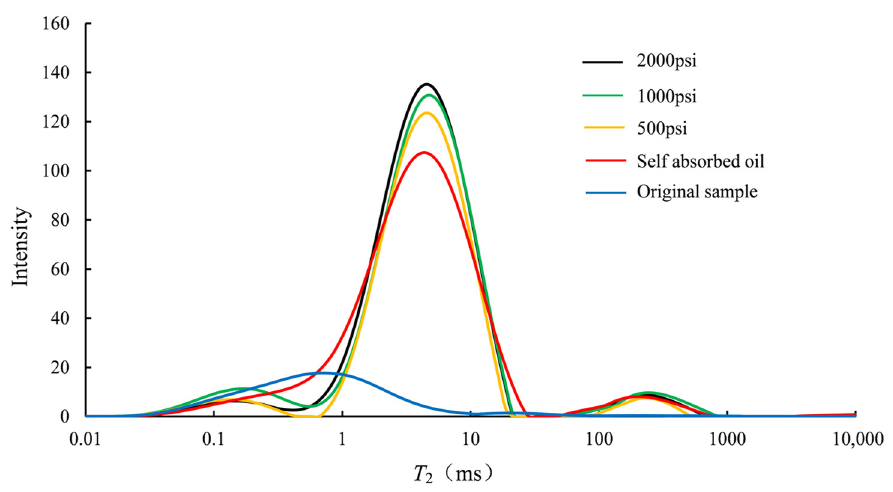
Figure 3. T 2 spectrum of the cylindrical sample (ZY1-1) in various states, including original, self- absorbed oil, and saturated oil under pressures of 500, 1000, and 2000 psi.